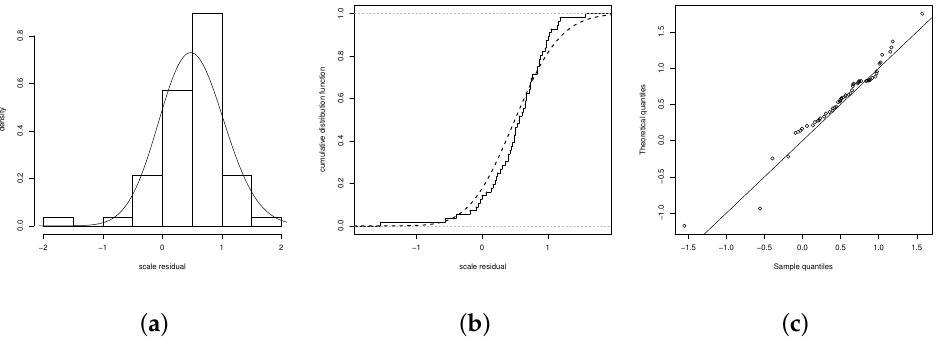
Figure 4. ( a ) histogram for scaled residuals CLGN model, ( b ) CDF of the scaled residuals CLGN model ( c ) qqplot for scaled residuals CLGN regression